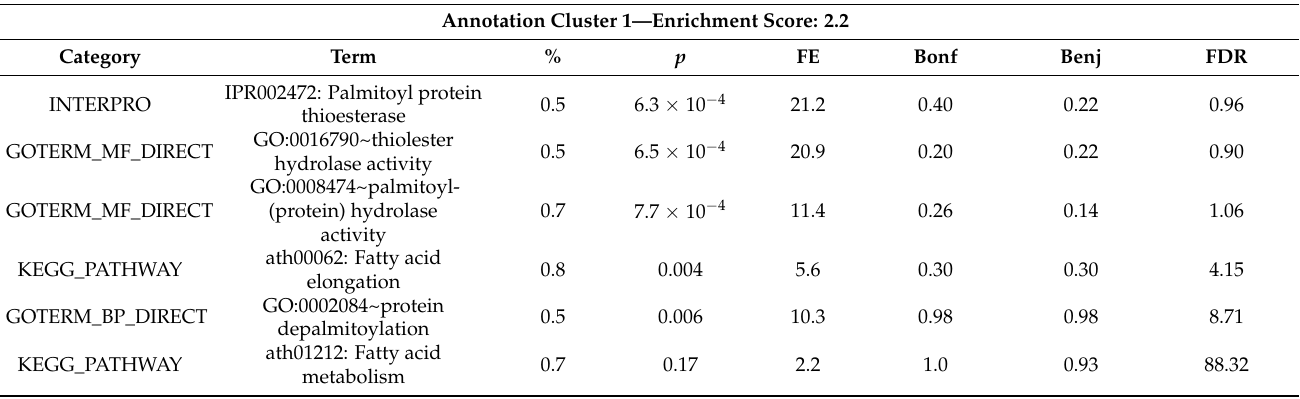
Table 3. DAVID functional analysis: functional annotation cluster (FAC) of differentially expressed genes in CTRS, Phylgreen, and Delfan Plus (Enrichment Score >2) recognized in DAVID database. Functional category, terms, p value, fold enrichment, and statistical significance (Bonferroni, Ben- jamini, and FDR). In the table, two annotation clusters (if available) with highest enrichment score for each treatment. CTRS Annotation Cluster 1—Enrichment Score: